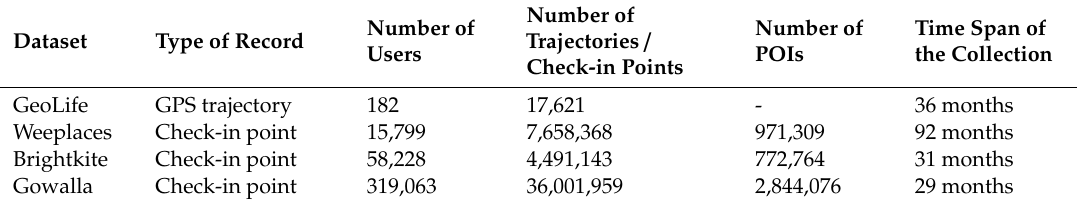
Table 2. Comparison of di ff erent datasets with respect to number of users, records, POIs and time span of the